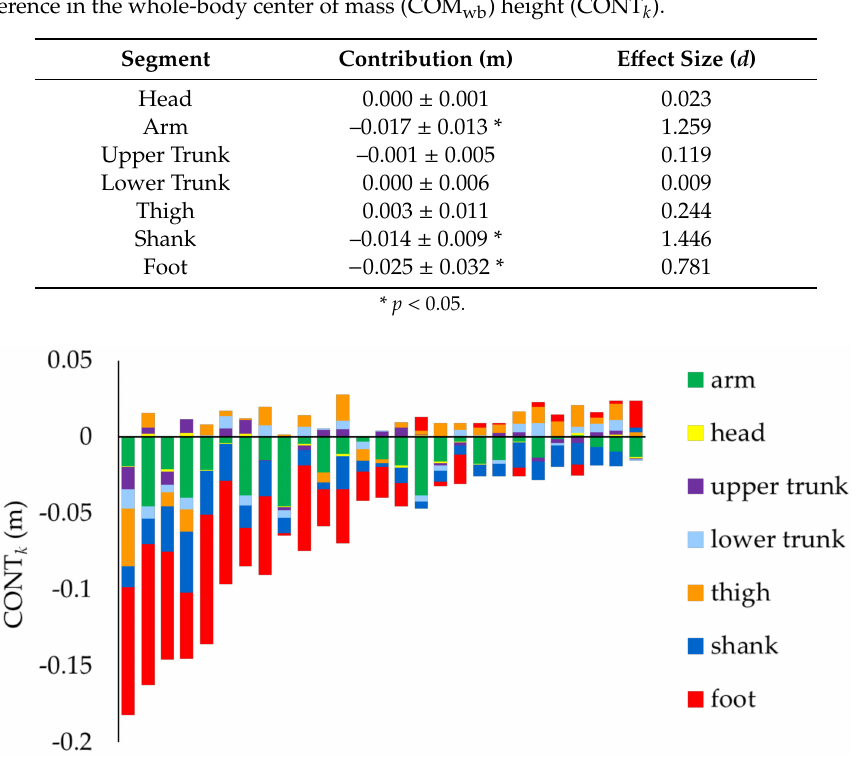
Figure 4. The contribution of the di ff erence in the vertical component of the segment length (SEG k ) to the di ff erence in the whole-body center of mass (COM wb ) height (contributions for all seven segments, CONT k ). The sum of the di ff erences in all of the segments is the di ff erence in the COM wb height. Each bar shows the result for a participant; the values are arranged in ascending